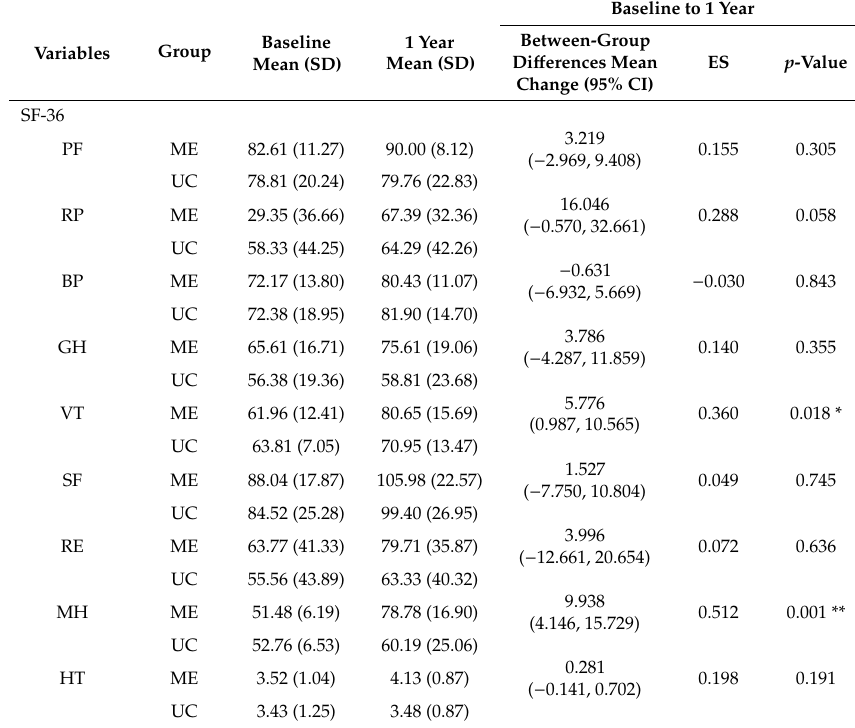
Table 2. Quality of life 1-year